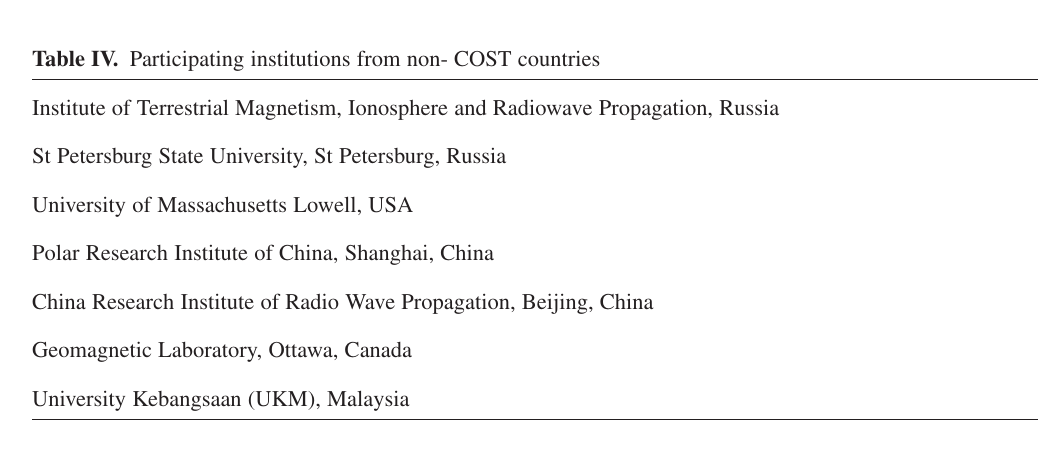
Table IV. Participating institutions from non- COST